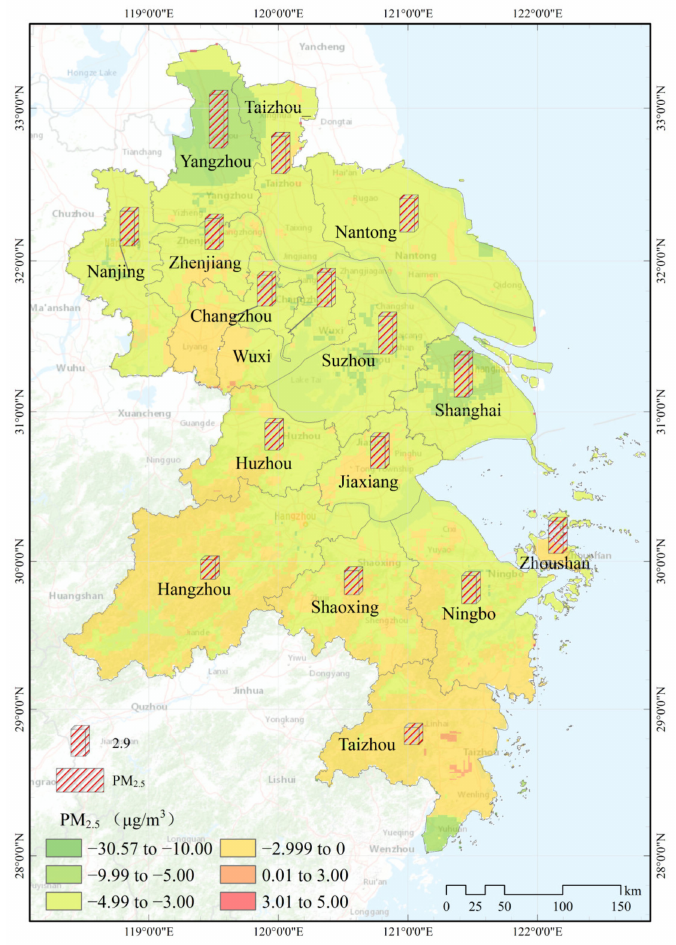
Figure 7. Reduction of city PM 2.5 in Yangtze River Delta during